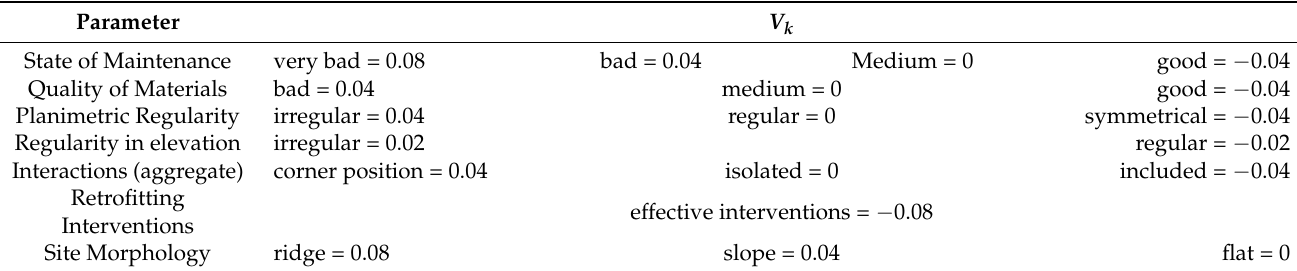
Figure 4. Fragility function: ( a ) curves for i v = 0.5, and ( b ) curves related to D k = 3 for different levels of vulnerability. Table 5. Reference values of modifiers scores ( V k ) (adapted from